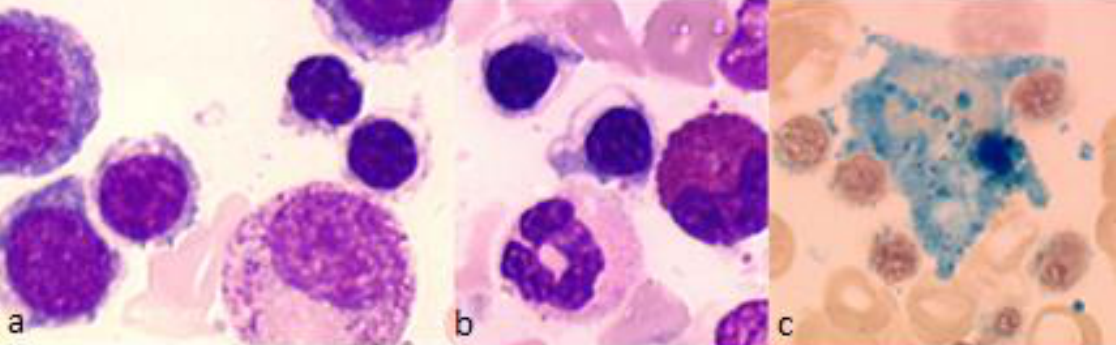
Figure 1. Representative bone marrow smears from a patient with congenital sideroblastic anemia XLSA with ALAS2 mutation. ( a , b ) Bone marrow smears showing vacuolated acidophilic erythroblasts and erythroid hyperplasia, May-Grünwald-Giemsa, magnification ×1000. ( c ) Perls ’ stain shows iron overloaded macrophages and ring sideroblasts, magnification ×500.